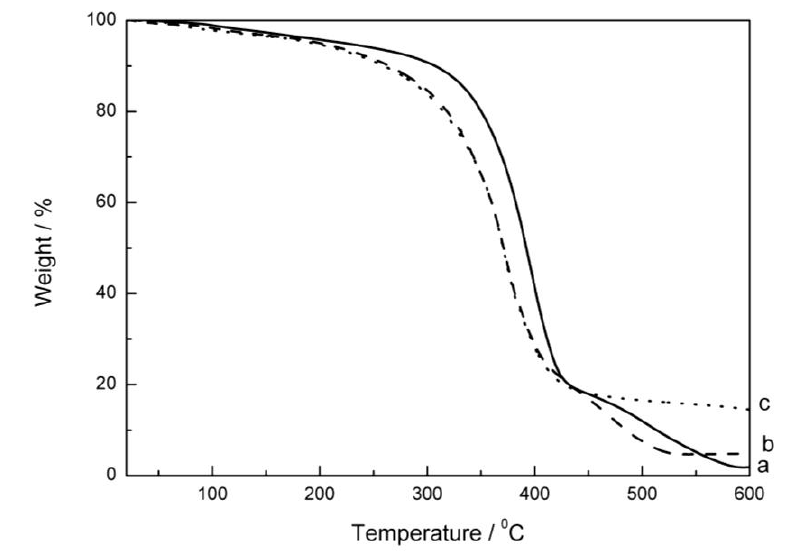
Figure 4. TGA curves of pure unsaturated polyester (UP) (a), OA–APS–ZnO/UP (b), and CDI–